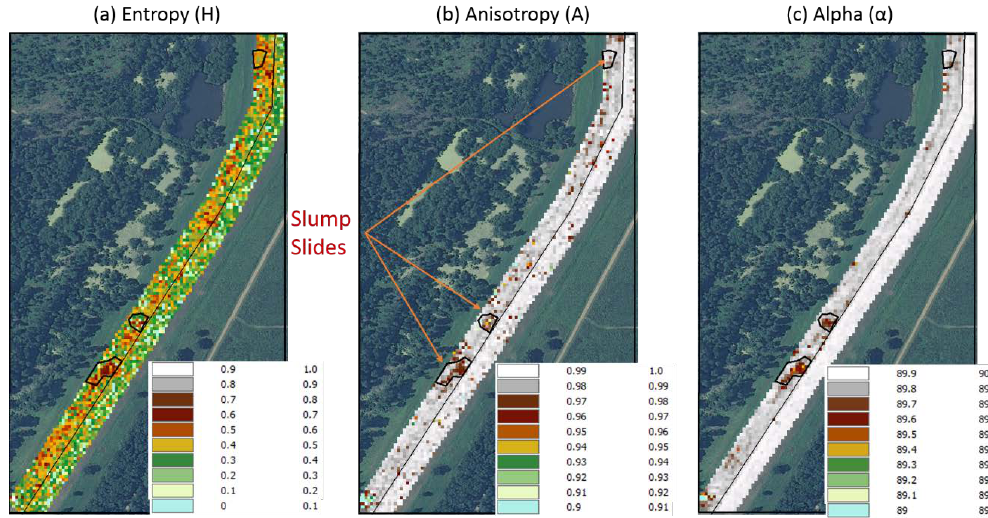
Figure 10. Polarimetric features from 16 June 2009 UAVSAR subset with optical NAIP imagery background. The slump slides are shown by the small black polygons in the images. ( a ) entropy (ranges from 0 to 1); ( b ) anisotropy (ranges from 0 to 1); ( c ) scattering angle (ranges from 0 ◦ to 90 ◦